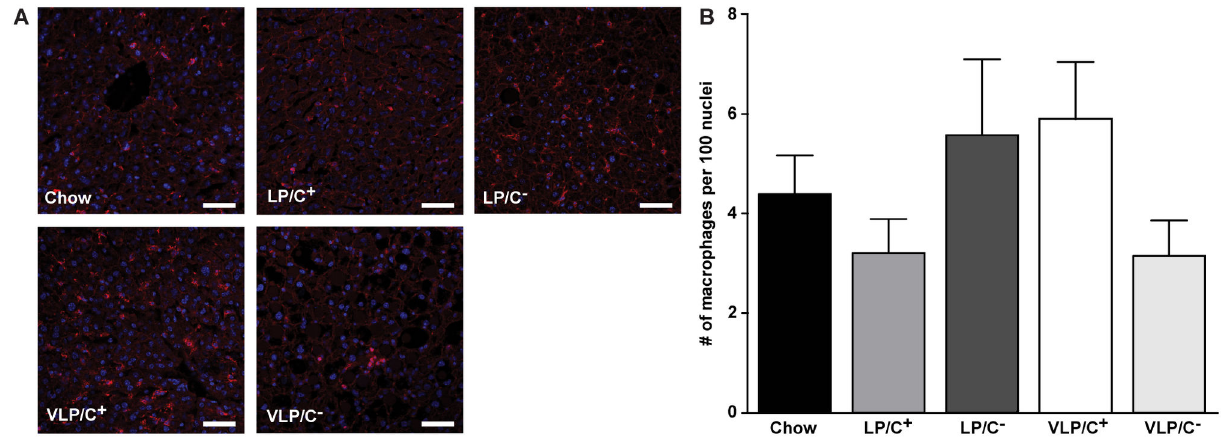
Figure 4. Hepatic macrophage density in mice fed very high fat, low protein, very low carbohydrate diets. ( A ) Confocal images of F4/80 + macrophages (scale bars, 50 μm) and ( B ) quantification of F4/80 + macrophages normalized to the number of DAPI-stained nuclei from liver sections of mice maintained on the indicated diets for 6 weeks. Data are presented as means±SEM. n=3 mice/group with n=3 20X fields quantified per